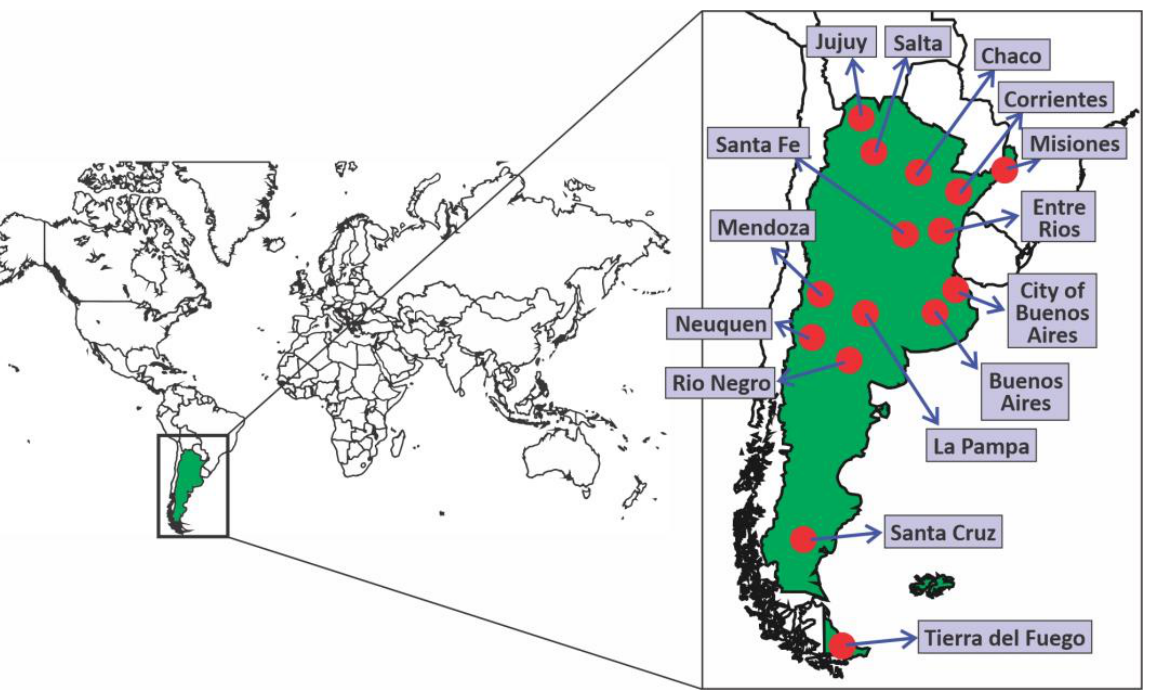
Figure 1. Sampling points for genomic surveillance of SARS-CoV-2 variants in Argentina.